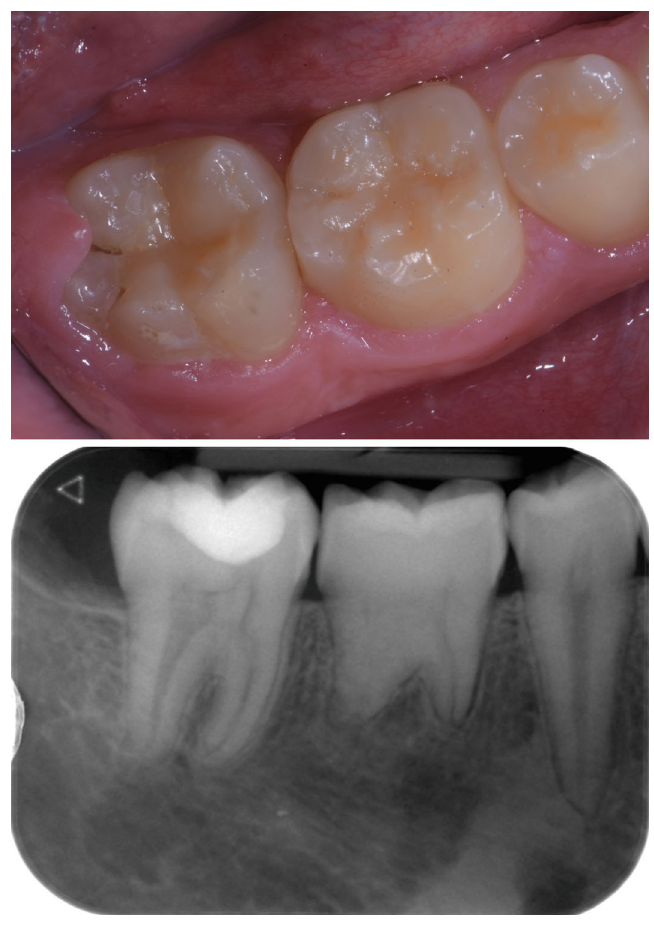
Figure 7: Tooth 46 at 2 years of follow-up.